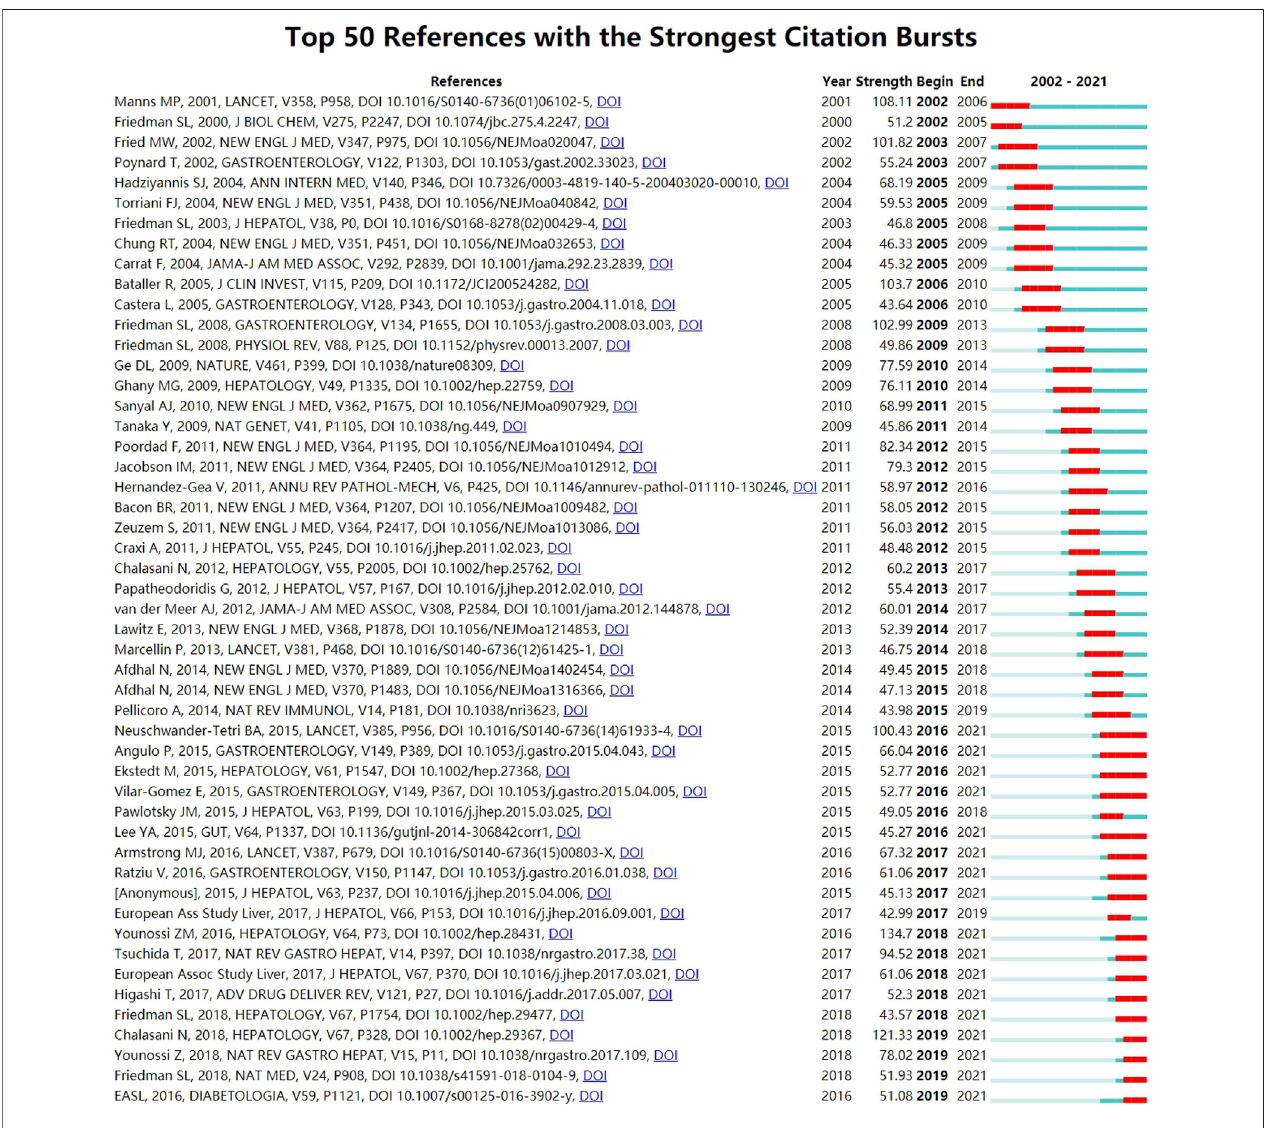
FIGURE 9 | View Citation Burst History. Notes: The blue bars mean the reference had been published; The red bars mean citation burstness.jpg.